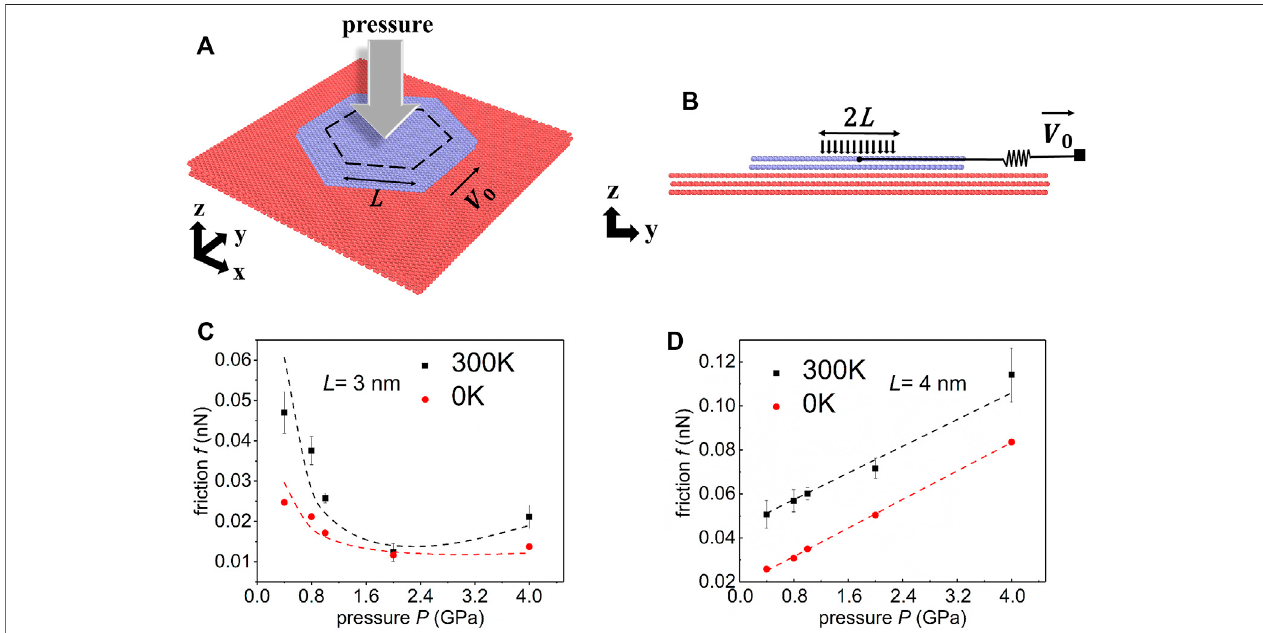
FIGURE 1 | Simulation model and main results. (A) Schematic sketch of the simulation model. A hexagonal graphene fl ake (purple) on the strained graphene substrate (red). The area enclosed by the dashed hexagon is the loading area. L is the side length of the loading area of the hexagon. (B) Side view of the simulation model. (C – D) Dependence between the friction force f and the loading pressure P for (C) the small loading area and (D) the large loading area. The zero temperature results and room temperature results are shown in red and black respectively. The dashed curves are fi tted with hook functions and linear